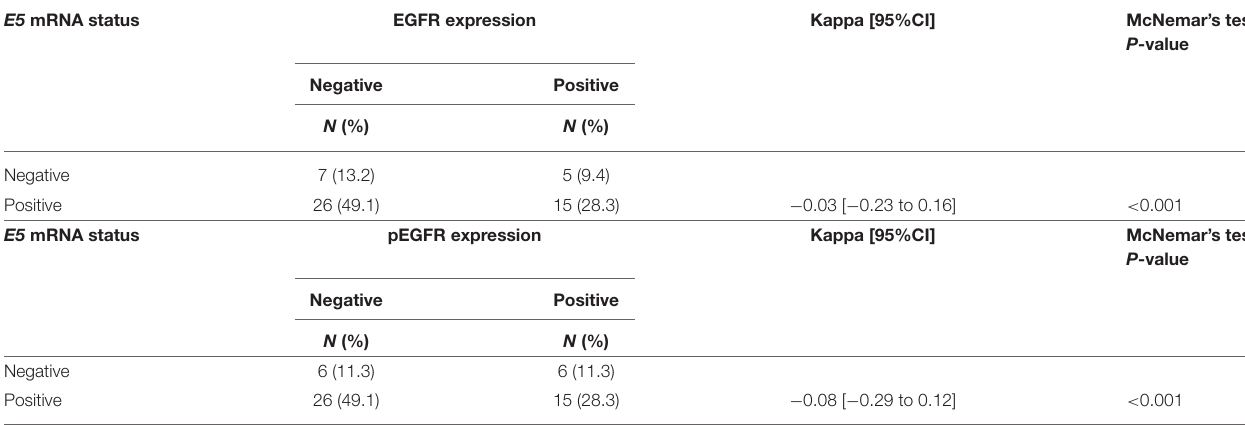
TABLE 2b | Concordance between HPV16- E5 expression and EGFR or pEGFR expression in HPV16 positive OPC cases.